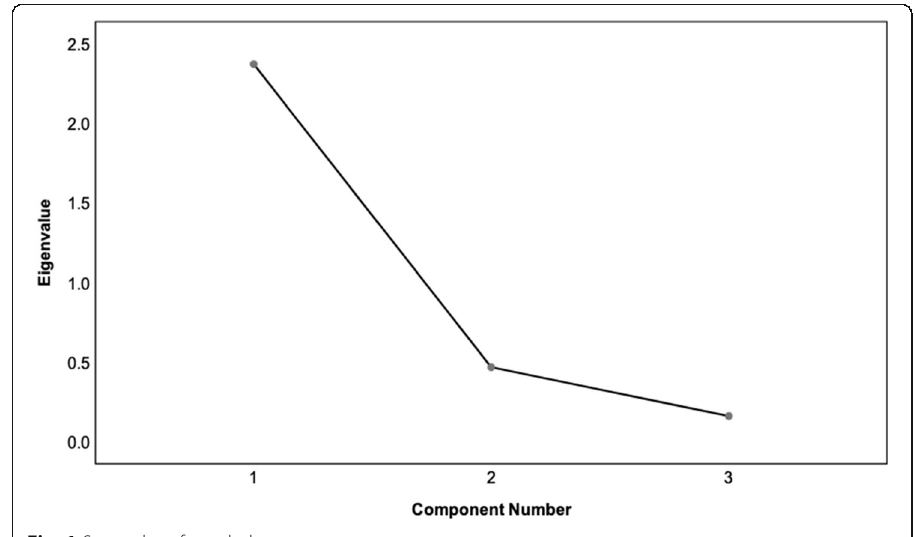
Fig. 1 Scree plot of vocabulary measures